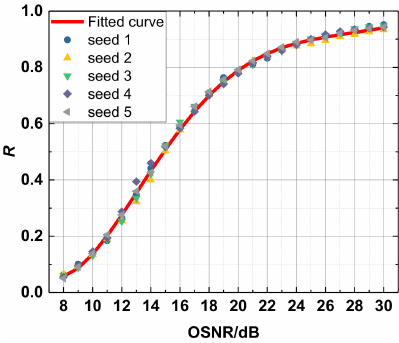
Figure 4. The value of R varies with di ff erent patterns of QPSK signal.